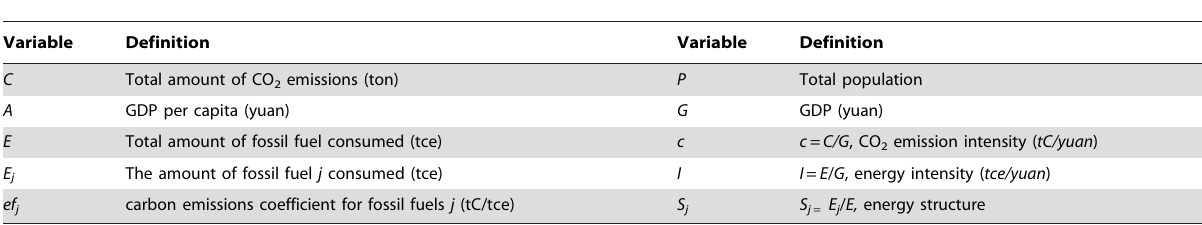
Table 1. Definitions of each variable in Eq.